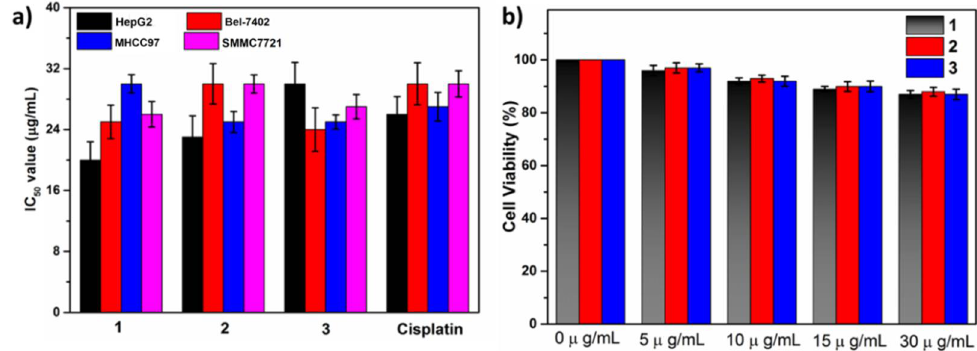
Figure 5. ( a ) Growth inhibitory effects of 1 – 3 and cisplatin against HepG2, Bel-7402, SMMC7721, and MHCC97 cells; and ( b ) cell viabilities of the human oral epidermal cells after incubation with 1 – 3 at different concentrations for 24